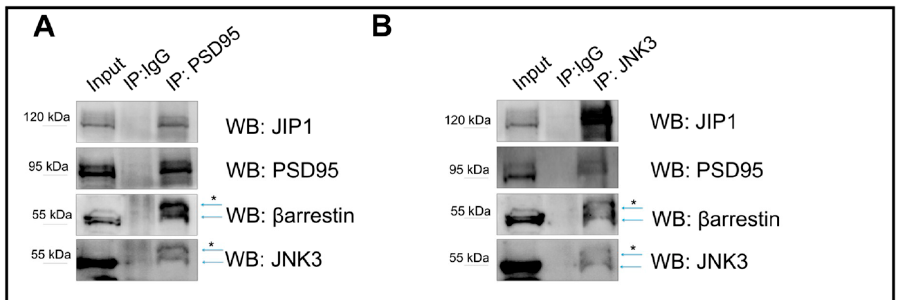
Figure 3. Immunoprecipitation outputs used to assess JNK3–JIP1– β -arrestin2–PSD95 colocalization in primary hippocampal neurons. ( A ) PSD95 was immunoprecipitated from the cell lysate homogenate using PSD95 antibody, and immune complexes were analyzed for the presence of JNK3, JIP1, and β -arrestin2. Immunoprecipitation with IgG antibody was used as a control. ( B ) JNK3 was immunoprecipitated from the cell lysate homogenate using JNK3-specific antibody, separated by SDS-PAGE, and analyzed via Western blot with anti-PSD95, anti-JIP1, and anti- β -arrestin2 antibodies. Immunoprecipitation with IgG antibody was used as a control. * indicates non-specific bands.